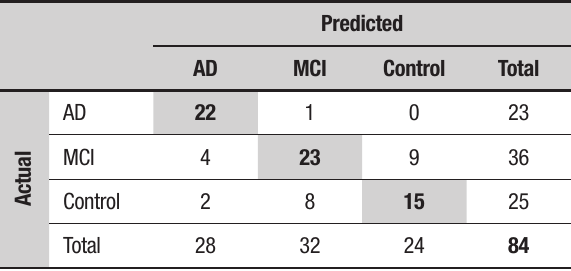
Table 4. Confusion matrix for M-ACE.